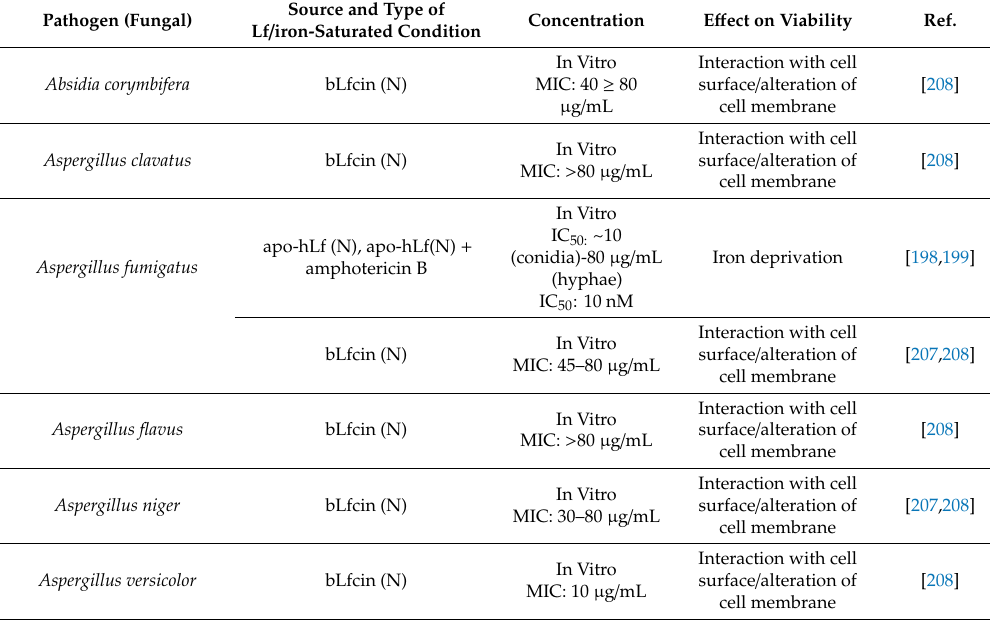
Table 3. E ff ects of lactoferrin and lactoferricins on pathogenic